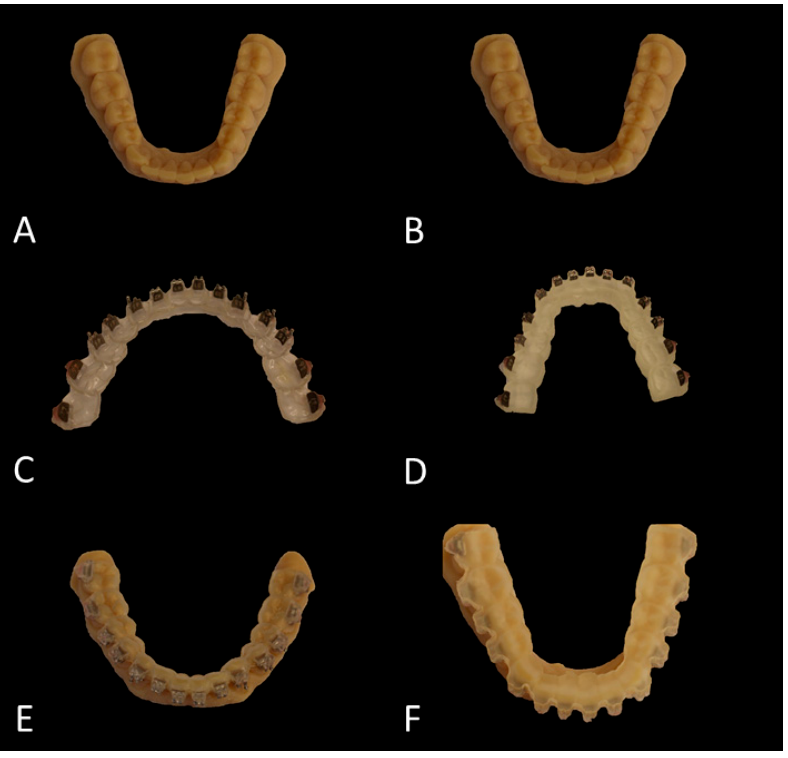
Figure 2. Overview of the bracket placement workflow. ( A , B ) Printed study models (SM). ( C , D ) Hard ( C ) and soft ( D ) tray with brackets placed inside the respective molds. ( E , F ) Printed casts with the brackets indirectly bonded by means of the hard ( E ) and soft ( F ) transfer tray.